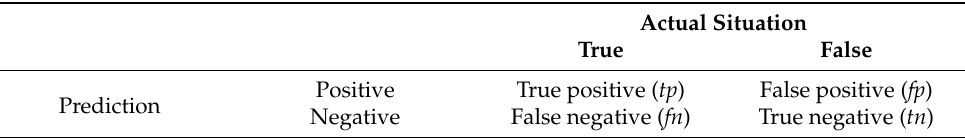
Table 1. Confusion